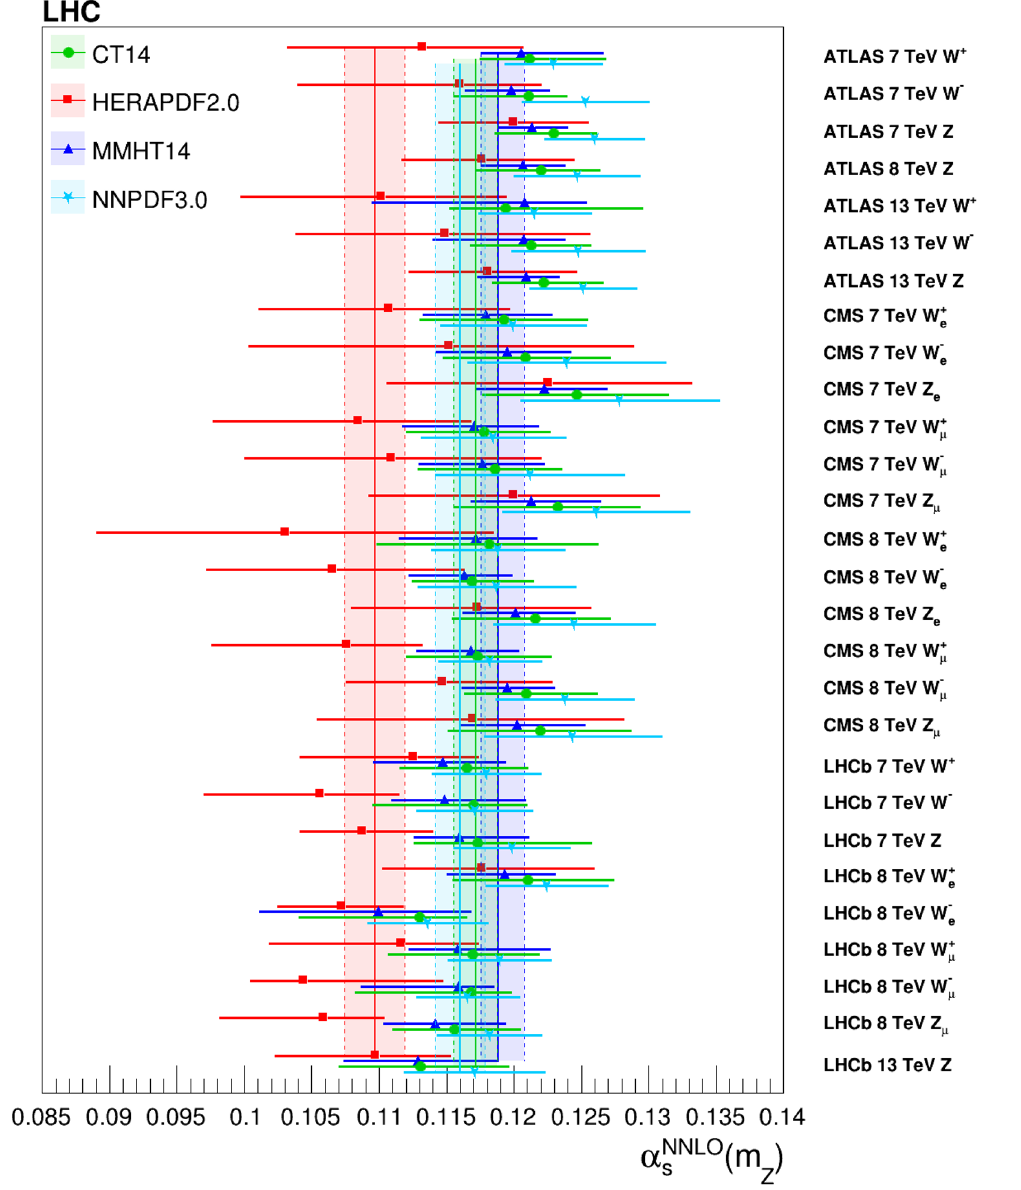
Figure 4 . Individual (cid:11) s ( m Z ) values extracted from each measured W (cid:6) and Z boson production cross section (symbols with error bars), and (cid:12)nal (cid:11) s ( m Z ) values obtained combining the 28 indi- vidual determinations (vertical coloured areas), for each PDF set. The CMS (cid:11) s ( m Z ) values plotted here are those derived in ref.